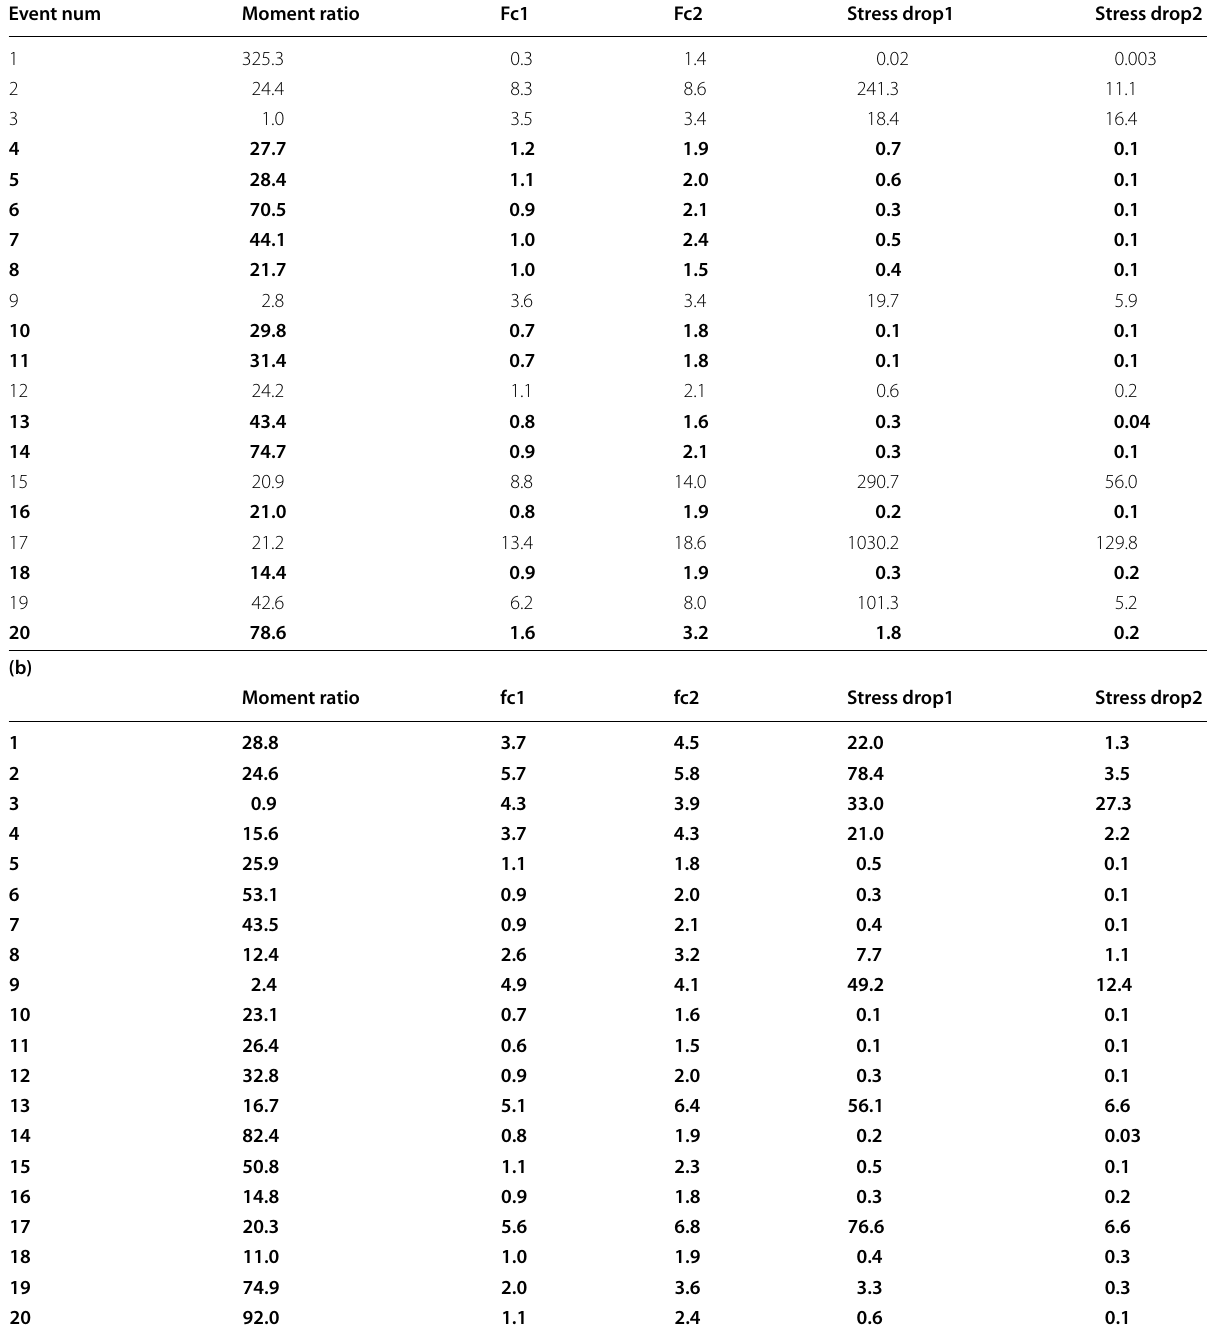
Table 3 (a) Estimated parameters for observational data assuming a F -distribution. From left to right, rows list event number, estimated moment ratio, corner frequency (Hz), stress drop estimated for a large earthquake (MPa), and the stress drop of a small earthquake (MPa). Events with thin characters mean that the event is not selected. (b) The estimated parameters for observational data assuming a normal distribution